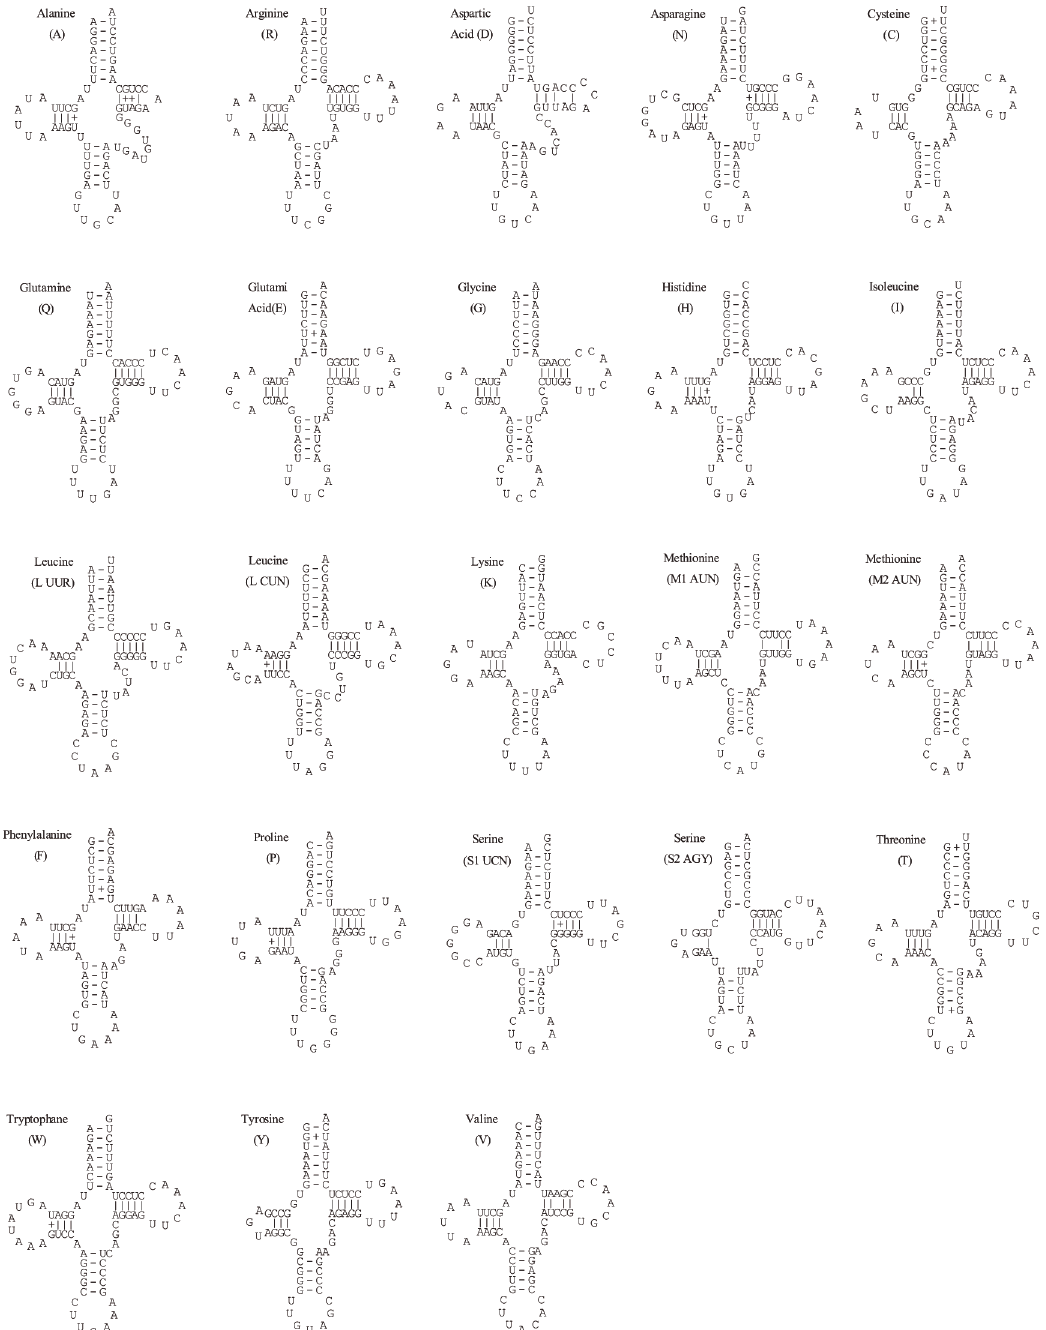
Fig 2. Predicted secondary structures for the 22 tRNA genes of H . rugulosus bred type. Dashes ( – ) indicate Watson – Crick base pairing and plus (+) indicate G+U base pairing. Arms of tRNAs (clockwise from the top) are the amino acid acceptor (AA) arm, the TyC (T) arm, the anticodon (AC) arm, and the dihydrouridine (DHU)